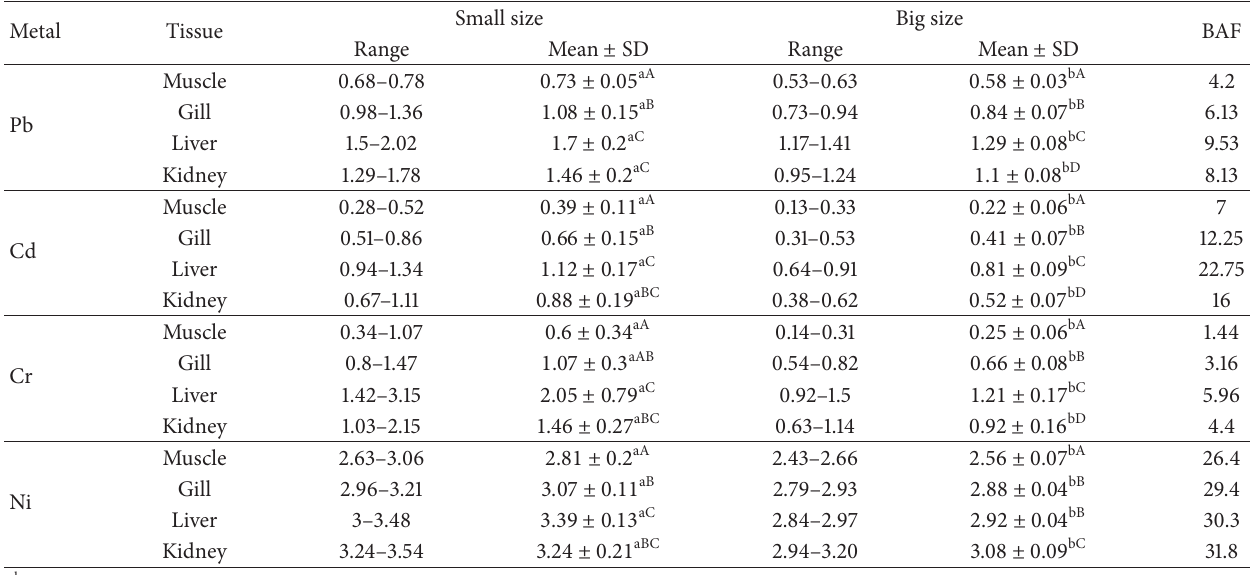
Table 2: Heavy metal concentrations in different organs ( 𝜇 g/gwet wt.) of P. indicus and bioaccumulation factor (BAF).